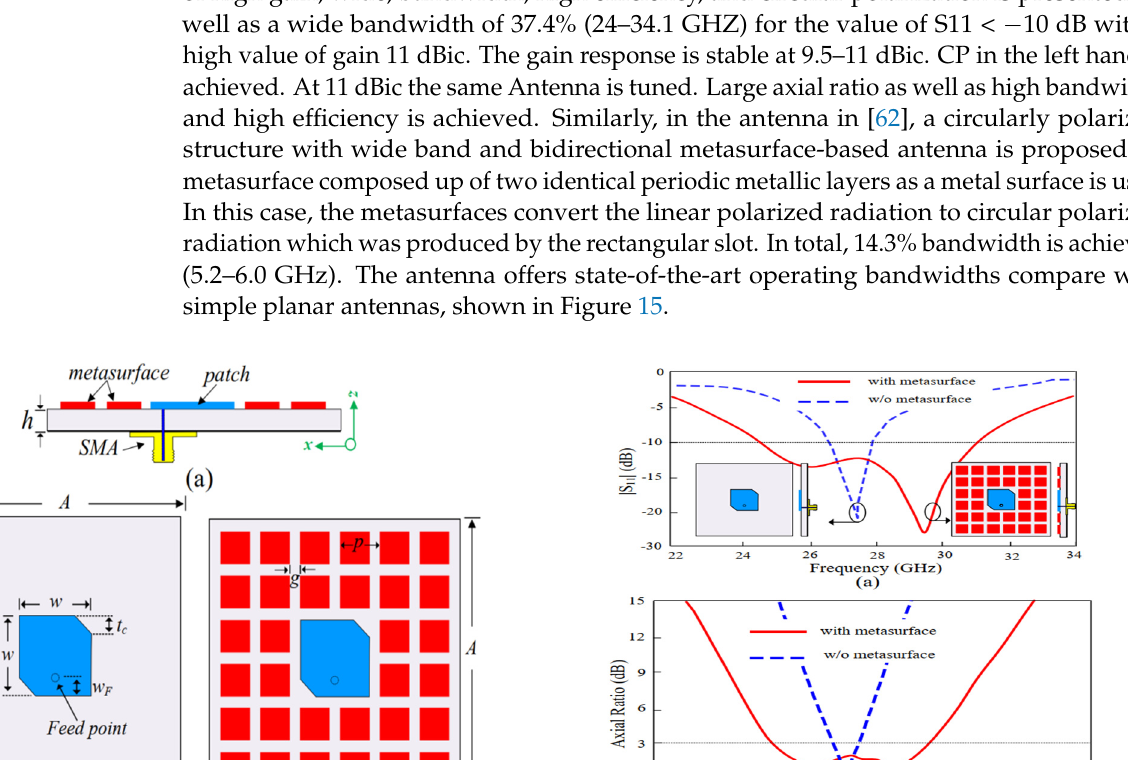
Figure 16. The geometrical configuration of the proposed DRA array. ( a ) 3D view. ( b ) Top view [62]. A 193.16% in [57,64] is achieved and four CSRRs in the ground plane are used. A total of 5.71% impedance bandwidth while the simple patch Antenna without the use of CSRRs offer an impedance bandwidth of 4.28% at 28 GHz.